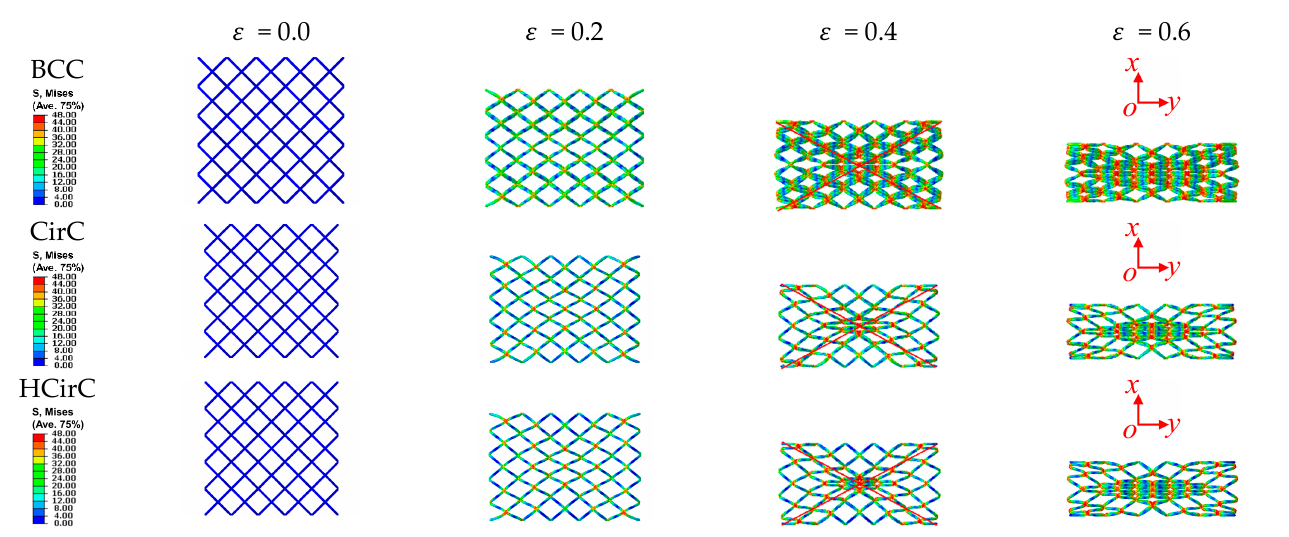
Figure 11. The compression behaviors of BCC, CirC, and HCirC (in XY-views, and the compression direction is along the 𝑥 -axis).